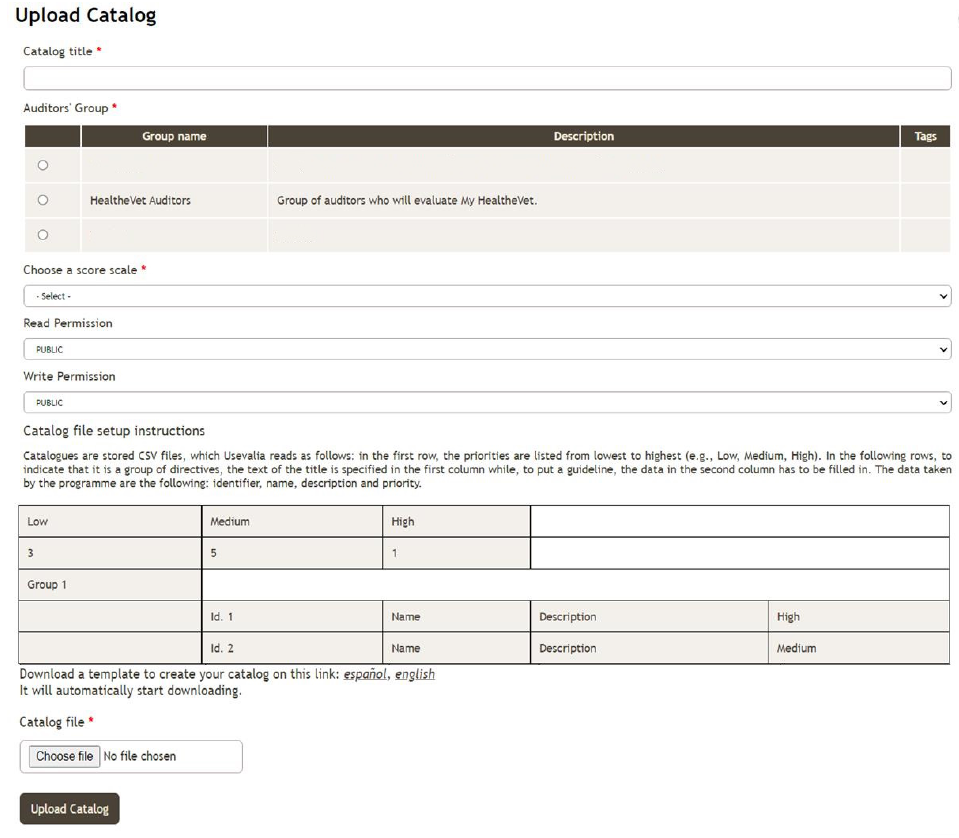
Figure 2. Usevalia’s upload catalogue functionality. The * indicates that the data is